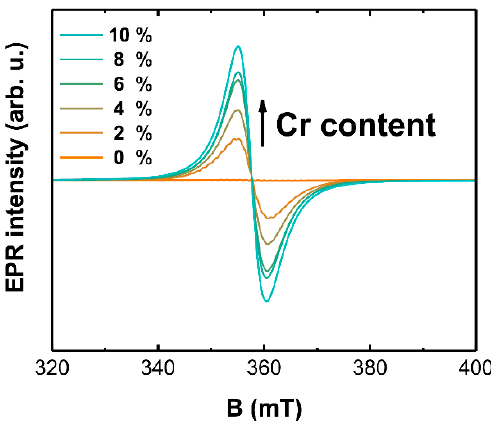
Figure 4. EPR spectra of LaOCl samples with different concentrations of Cr.